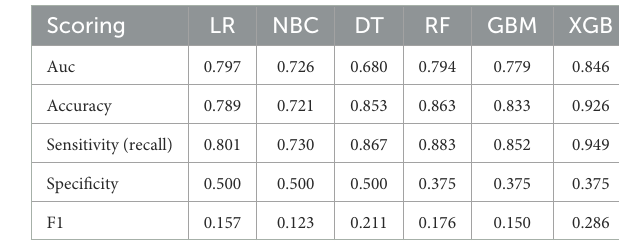
TABLE 3 The result of specific performance of six ML algorithm